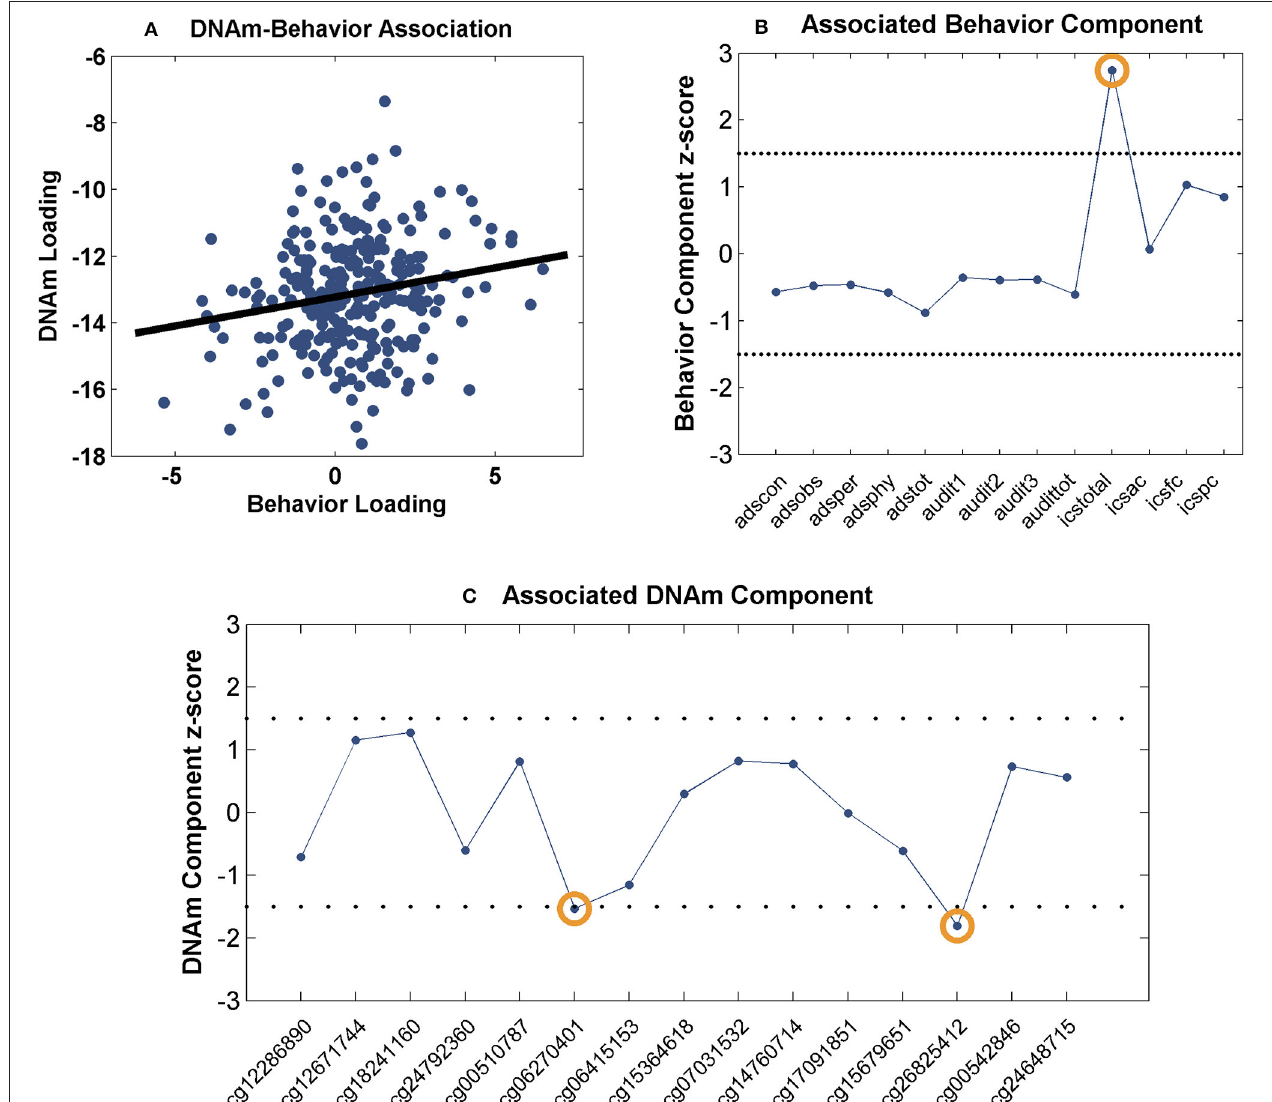
FIGURE 1 | Association between the identified CpG sites and behavioral measures: (A) Scatter plot of the methylation and behavior component loadings; (B) Scatter plot of the associated behavior component; (C) Scatter plot of the associated methylation component. The dashed lines represent threshold of |z-score| > 1.5.